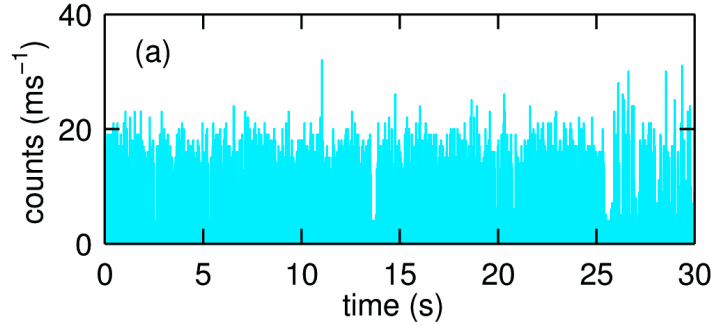
Figure 11. ( a ) Typical binned time trace (1 ms bin time) of a turning over single SLAC molecule. The molecule shows fluctuations between the high and low emission rates as the redox state of T1 Cu changes which can be seen more clearly from a small portion of the trace as shown in ( b ). Reprinted with permission from [43]. Copyright 2014 The American Chemical